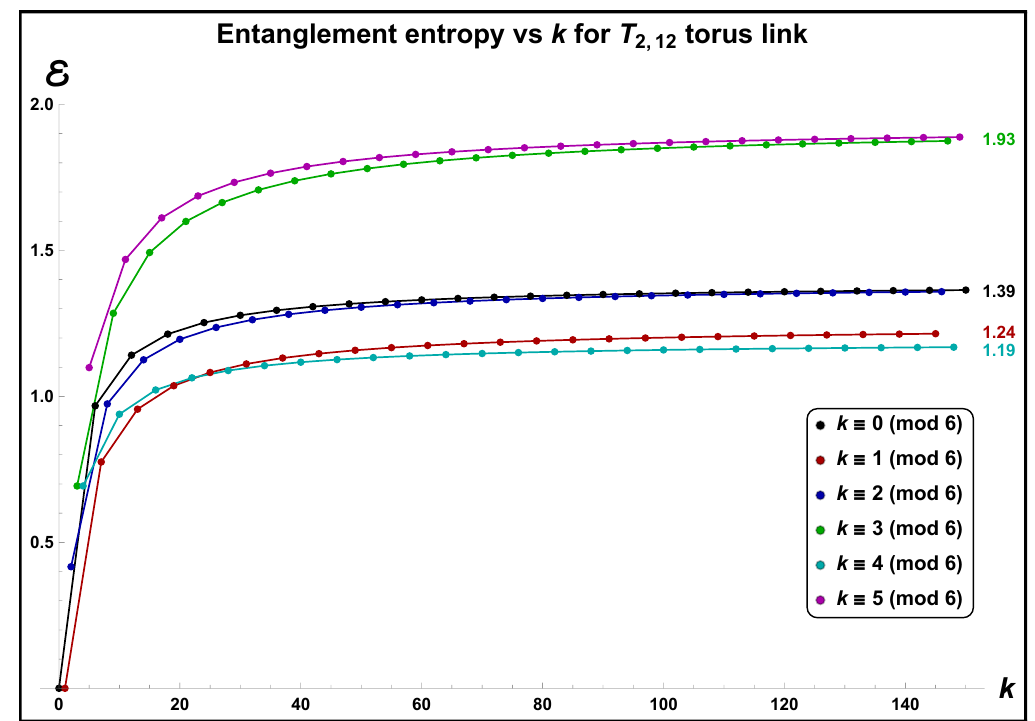
Figure 10. The variation of the SU (2) k entanglement entropy with k computed for the link T 2 , 12 . The entropies have been plotted for k ≡ ‘ ( mod 6) . The asymptotic limits are given in (4.46) and are indicated against each plot in the